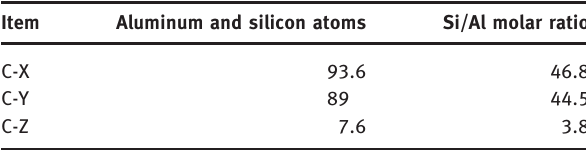
Table 3: Silica alumina ratio of the three kinds of molecular sieve catalyst (conditions: aluminum and silicon atoms and the molar ratio Si/Al of C-X, C-Y, and